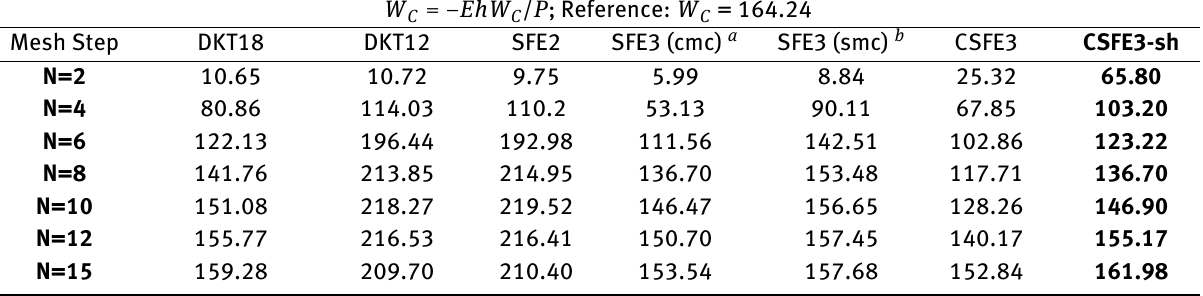
Table 3: Transverse displacements results W C at point C